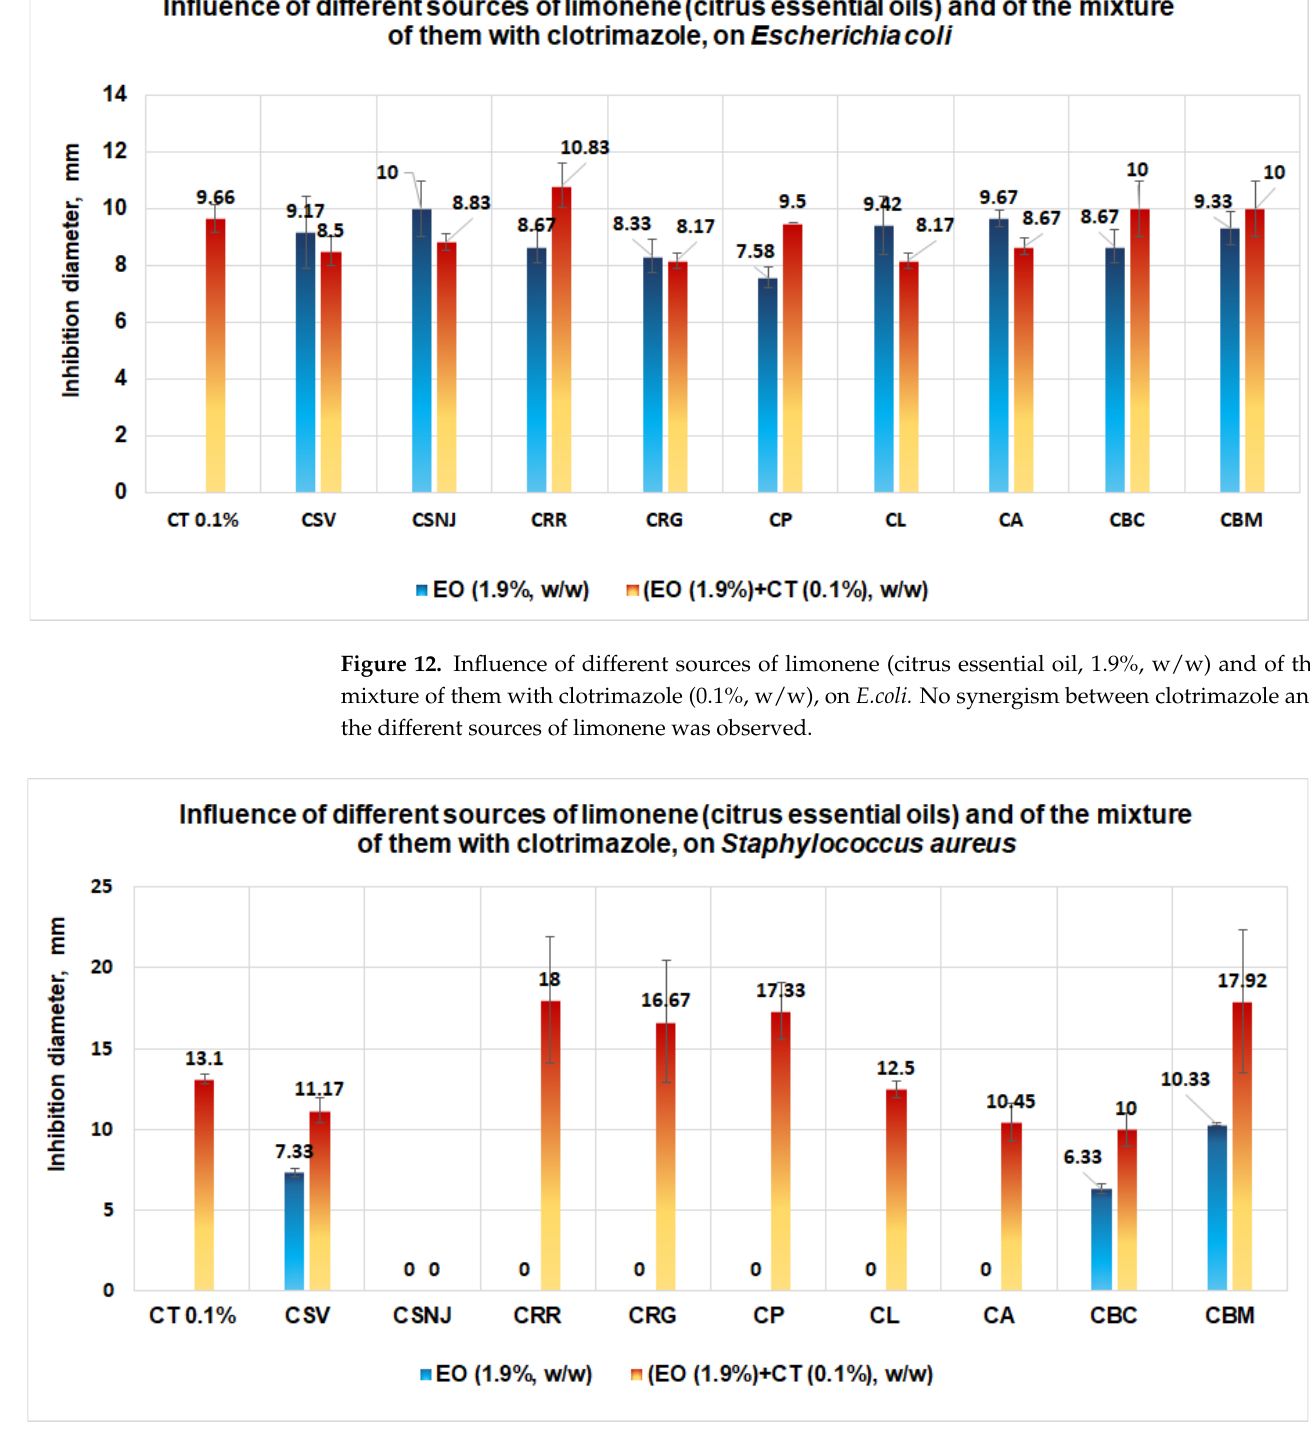
Figure 13. Influence of different sources of limonene (citrus essential oil, 1.9%, w/w) and of the mixture of them with clotrimazole (0.1%, w/w) on S. aureus. The synergistic effect is evident in the case of the mixtures between clotrimazole and the essential oils of mandarin (red mandarin or green mandarin), and, respectively, between clotrimazole and the essential oil of